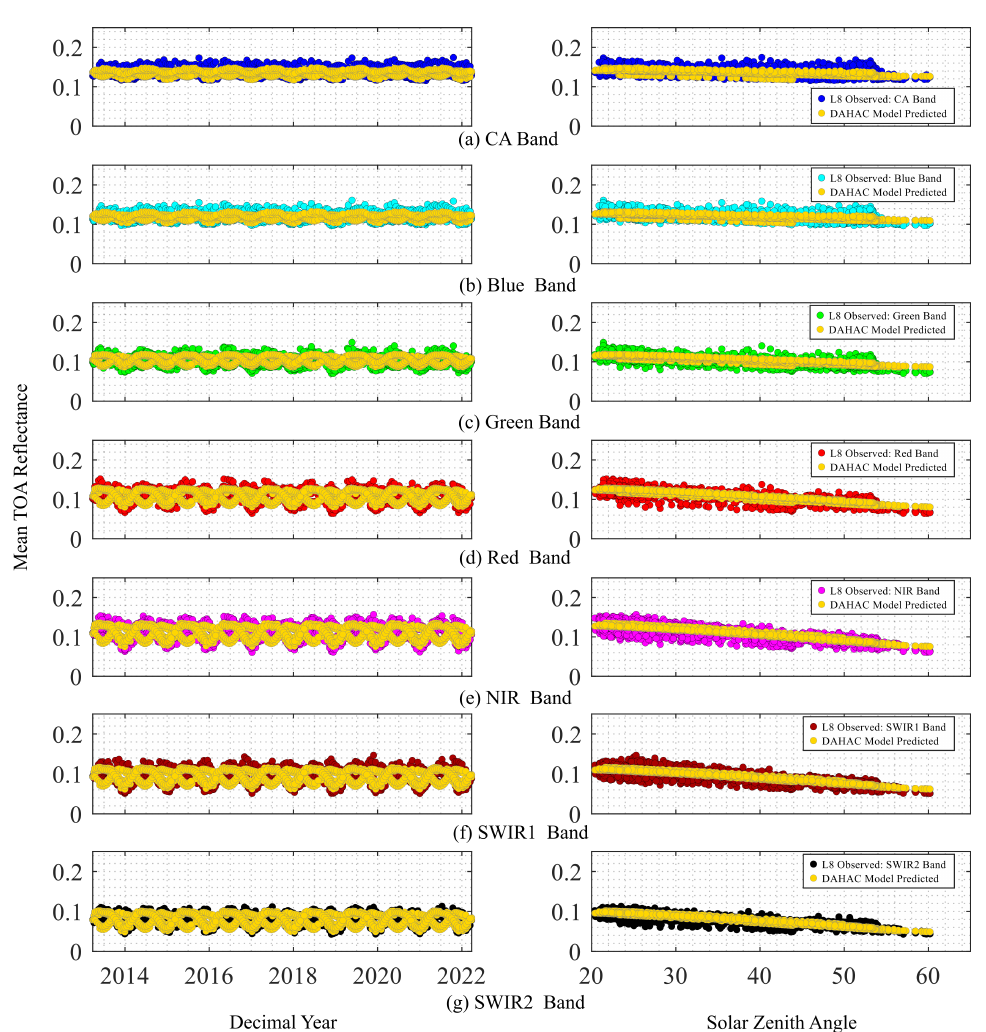
Figure 20. DAHAC model validation on L8 across seven spectral bands. The left-hand side plots with respect to the decimal year show the seasonal variation and were well-captured by the model for every band. The right-hand side plots show the decreasing linear trend of the observed TOA reflectance with respect to the SZA, and the DAHAC model- predicted TOA reflectance agreed well with L8 measurements for all spectral bands.